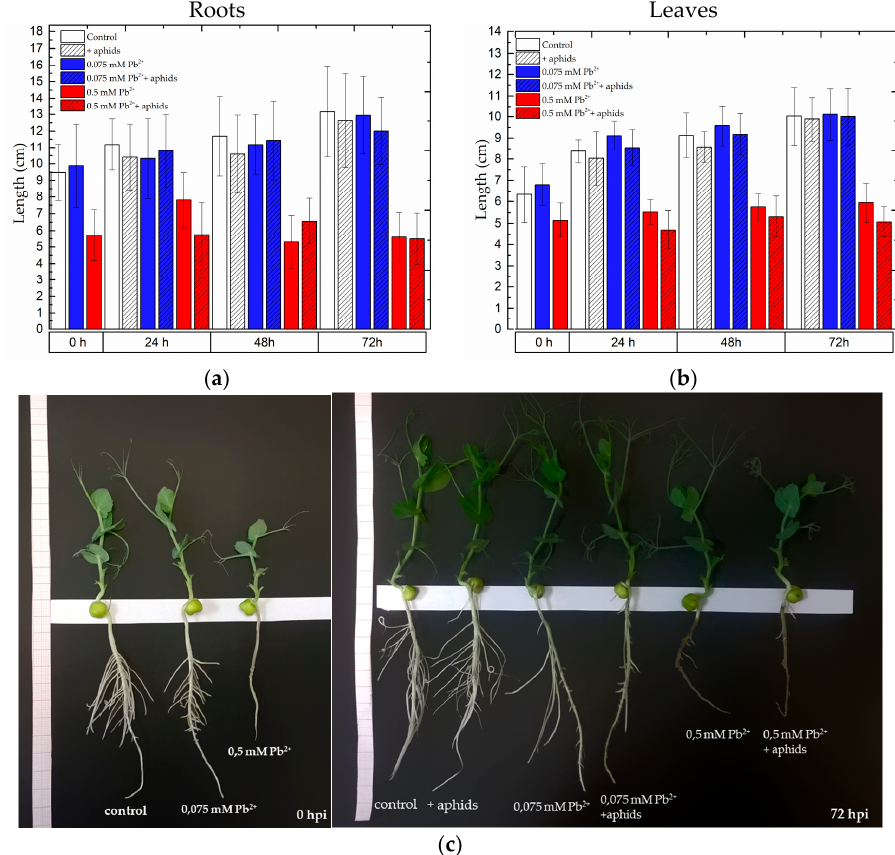
Figure 9. The effect of lead and A. pisum on growth of roots ( a ) and shoots ( b ) of pea seedlings. Pea seedlings after 4 days from the administration of lead and prior to transferring aphids onto pea seedlings (at 0 h) and 72 h after pea aphid infestation; ( c ). The data were obtained in ten independent experiments and statistically analysed using ANOVA ( p -values at α = 0.05). Hypotheses on the equality of means were verified by the two-sample t -test. To account for multiple testing, we used the Bonferroni correction (statistically significant differences are shown in Table S1).